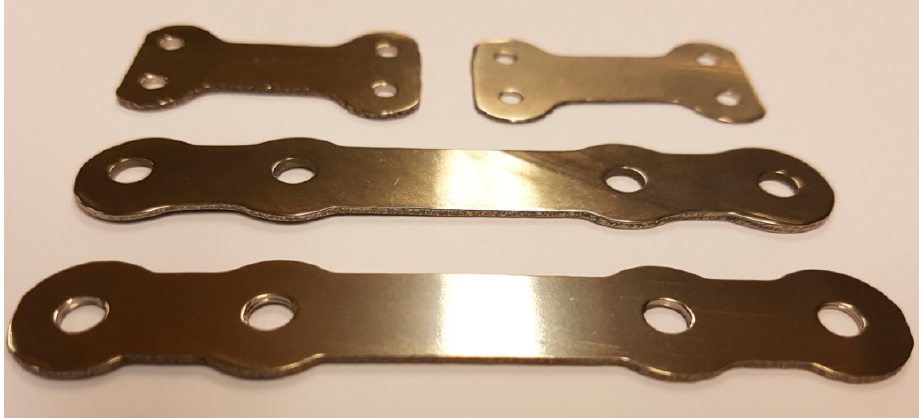
Figure 15. Photo of bone plates in the final form produced by Laser Melting Deposition (LMD) and mechanically processed for dimensions and roughness requirements.